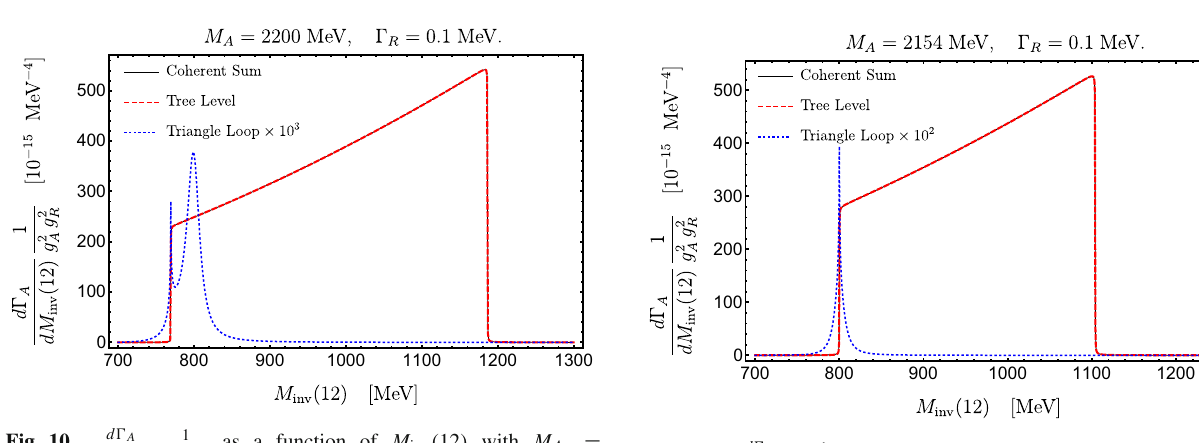
1 Fig. 11 d (cid:4) A as a function of M inv ( 12 ) with M A = dM inv ( 12 ) g 2 A g 2 R 2200 MeV and (cid:4) R = 0 . 1 MeV. Here (cid:4) BW → 2 (cid:4) BW to account for the inelasticities. The dashed and solid lines are indistinguishable in the figure